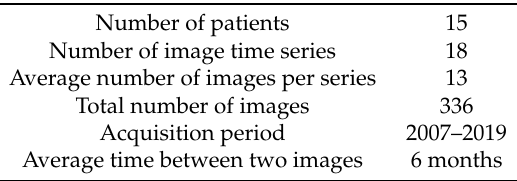
Table 2. Description of the